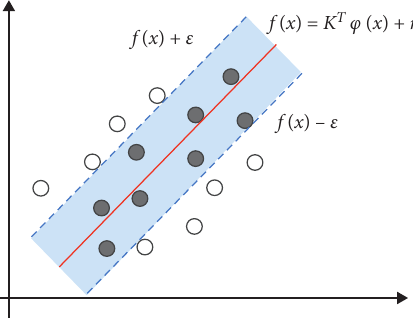
Figure 6: Schematic diagram of the SVR method.